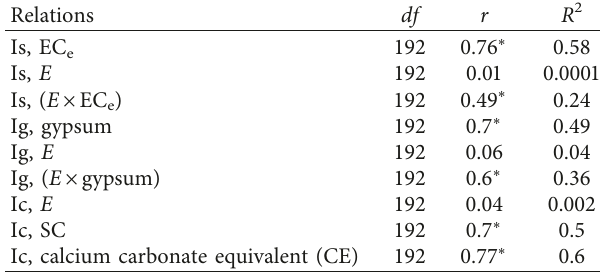
Table 5: Correlations between indices of Solonchaks (Is), Calcisols (Ic), and Gypsisols (Ig) and different diagnostic criteria.